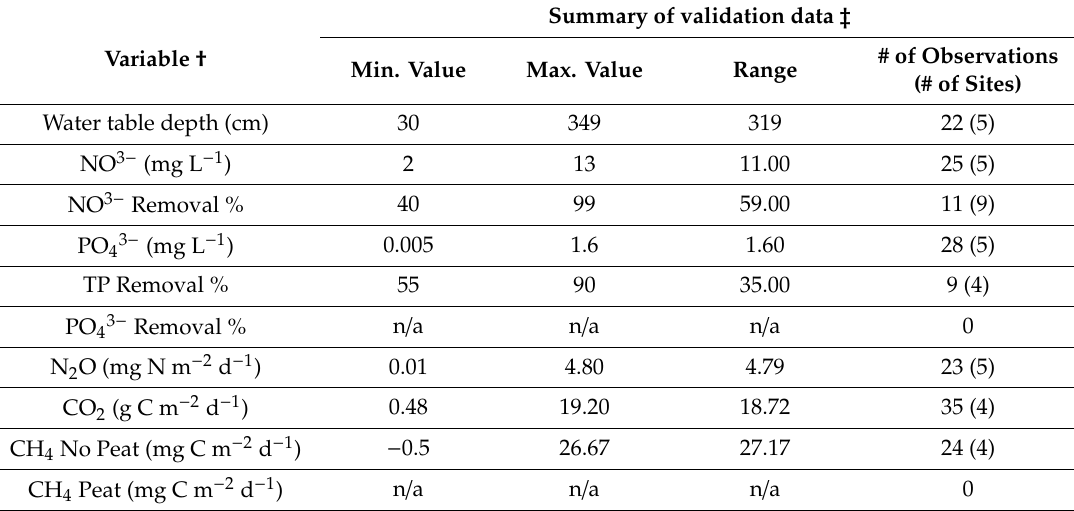
water table = water table depth below ground surface. ‡ : n / a and zero values indicate that although model estimates were compared with known literature values in the discussion section, no independent validation sites directly applicable to the RZ-TRADEOFF model were found in the